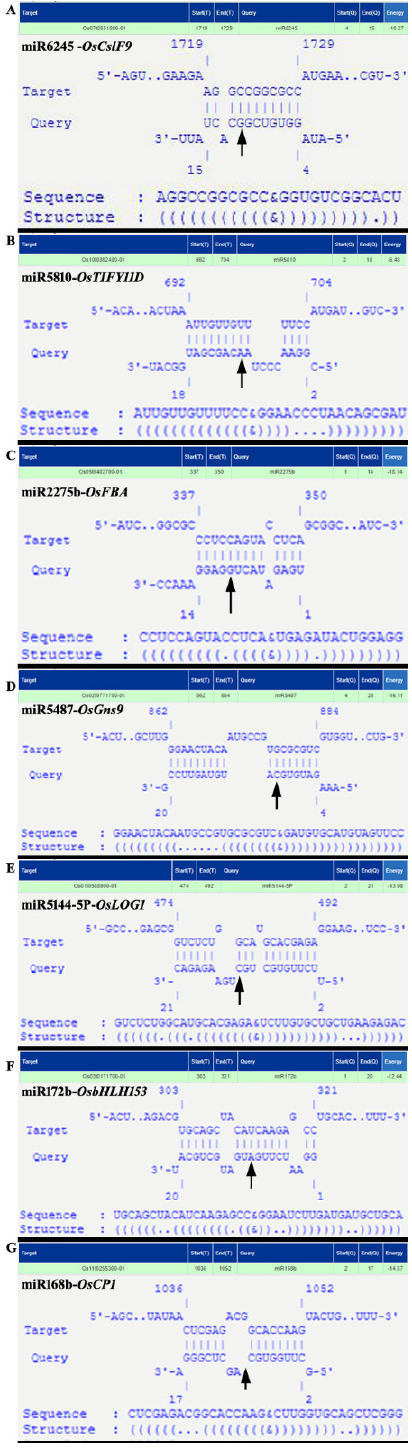
Figure 7. Some of the randomly selected miR–target pairs are presented with their complementary binding and cleavage site. The cleavage sites (CSs) are indicated with black arrows. The complementary binding was observed with the IntaRNA2.0—RNA–RNA Interaction tool (http://rna.informatik.uni-freiburg.de, accessed on 1 January 2022) [60]. The complementary sequence specific binding and CS of ( A ) miR6245 and OsCSIF9 , ( B ) miR5180 and OsTIFY11D , ( C ) miR2275b and OsFBA , ( D ) miR5487 and OsGns9 , ( E ) miR5144-5p and OsLOG1 , ( F ) miR172b and OsbHLH153 , ( G ) miR168b and OsCP1